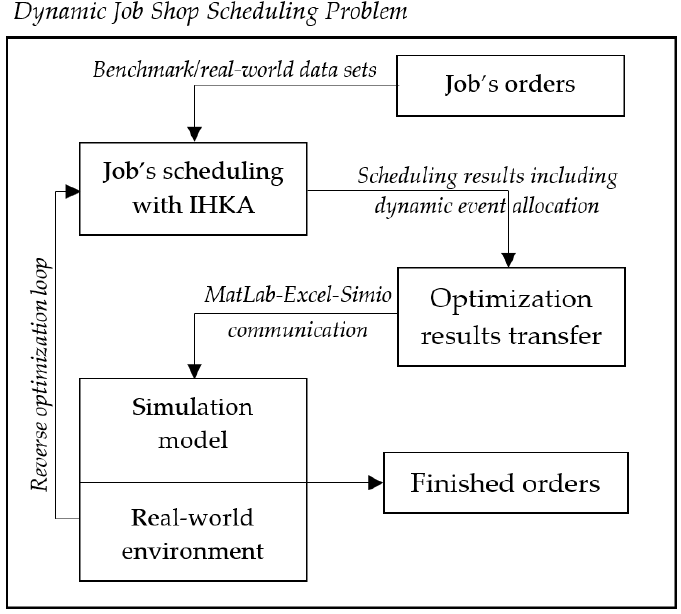
Figure 1. The proposed integration-communication protocol.